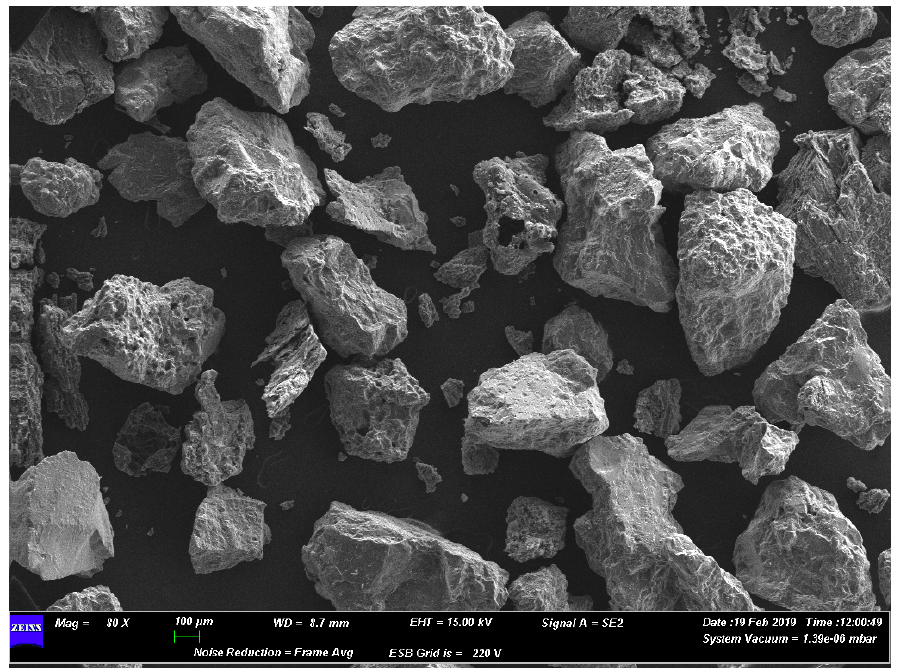
Figure 8. SEM analysis of olivine after the test .